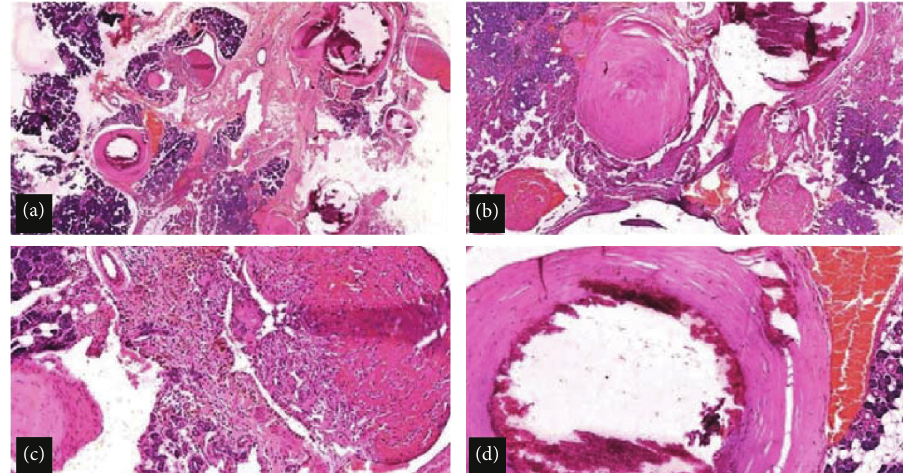
Figure 5: (a) Scanner photomicrograph shows thick- and thin-walled blood vessels traversing the parotid parenchyma. Thrombi and calcification are seen within the lumen ( H and E x40); (b) low-power photomicrograph shows thrombi in varying stages of organisation. Marked calcification seen in one of the vessels ( H and E x100); (c) some of the vascular spaces show organising thrombus with revas- cularization ( H and E x100); and (d) low-power photomicrograph shows luminal as well as focal calcification within the wall ( H and E